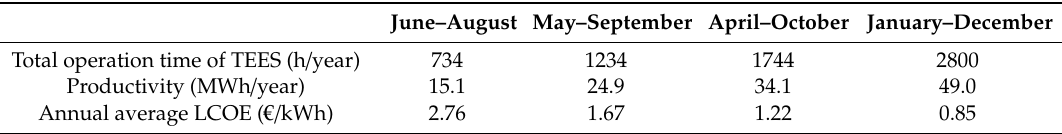
Table 6. Annual operational details for TEES systems operated in Crotone (39.08 ◦ N, 17.11 ◦ E), considering di ff erent possible working